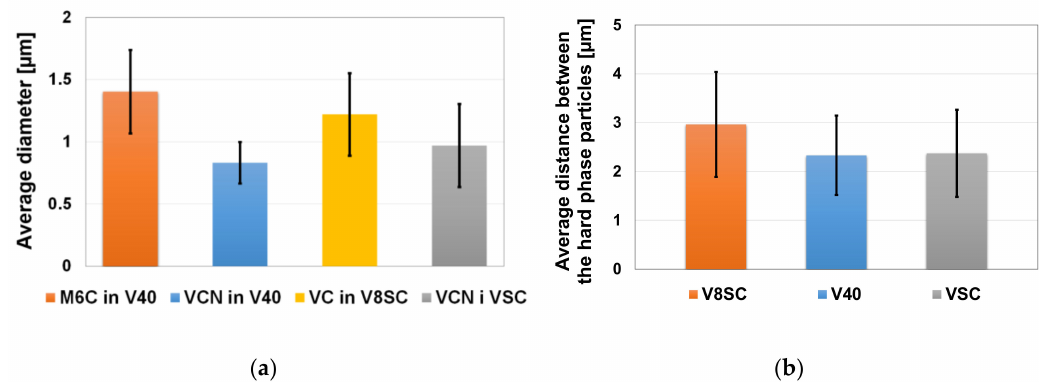
Figure 5. Measurements of the hard phase presented in the tool steel matrices: ( a ) the average diameter of the particles and ( b ) the average distance between the hard phase particles.